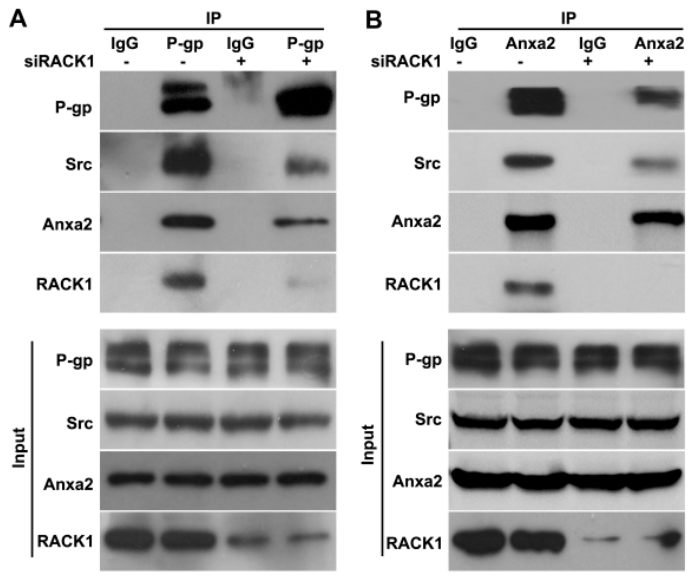
Figure 4. Knockdown of Rack1 attenuates the interaction of P-glycoprotein with Anxa2 and Src. ( A ) The interaction of P-gp with Anxa2 and Src in Rack1 depletion cells was significantly attenuated compared with that of control cells. Control and Rack1 knockdown MCF-7/ADR cells were lysed, immunoprecipitated with anti-P-gp antibody and then analyzed by Western blotting with anti-P-gp, Rack1, c-Src or Anxa2 antibody; ( B ) Silencing of Rack1 expression significantly attenuated the interaction of Anxa2 with P-gp and Src. Control and Rack1 knockdown MCF-7/ADR cells were lysed, immunoprecipitated with anti-Anxa2 antibody and then analyzed by Western blotting with anti-P-gp, Rack1, c-Src or Anxa2 antibody.